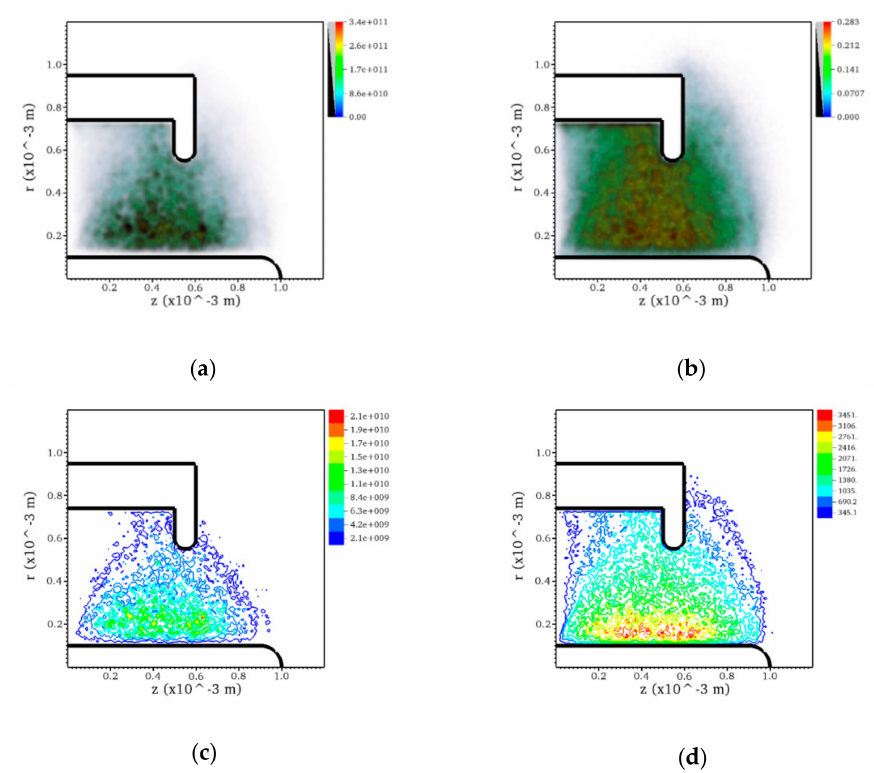
Figure 6. Distribution of event number ( a ) and neutral particles energy (eV) ( b ) in elastic collision. Distribution of event number ( c ) and ions particles energy (eV) ( d ) in ionization collision, (400 A, 100 V, 4 g /